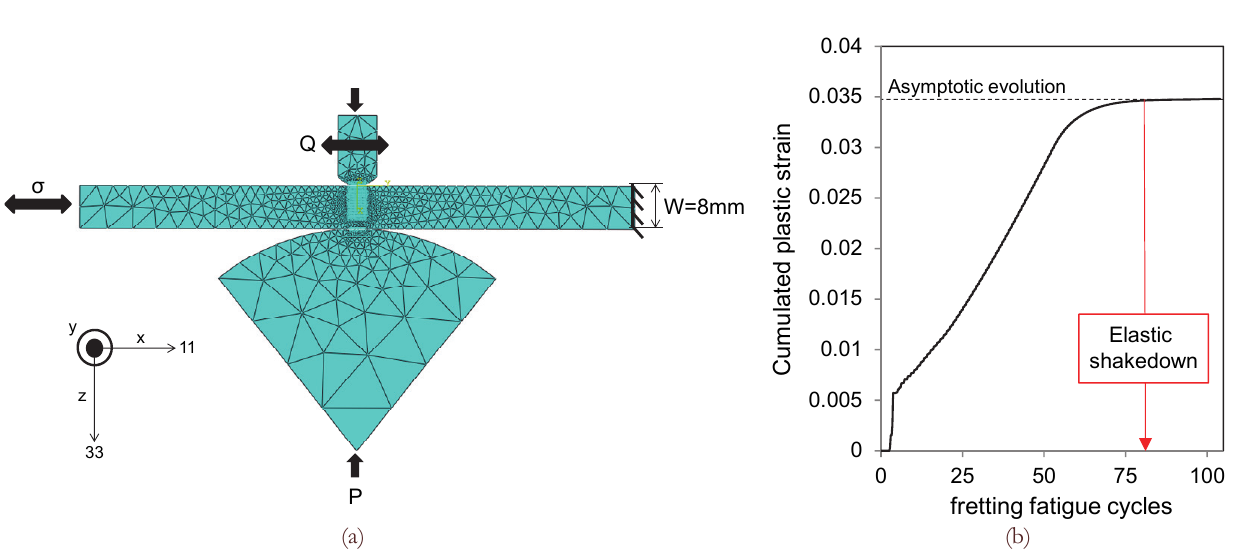
Figure 5: (a) Abaqus model of the test. (b) Cumulative plastic strain evolution simulated at the contact border hot spot for a crack